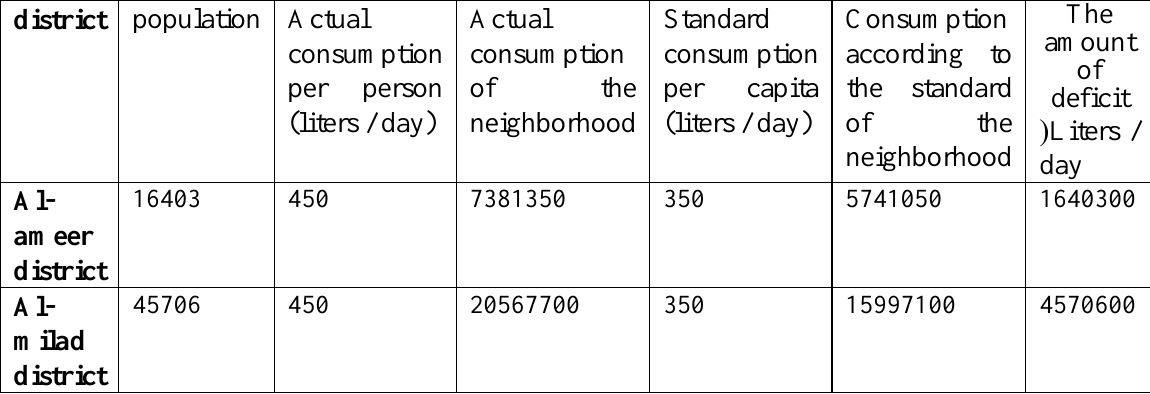
Table 7. The amount of deficit in the rate of daily water consumption / source: the researcher. district